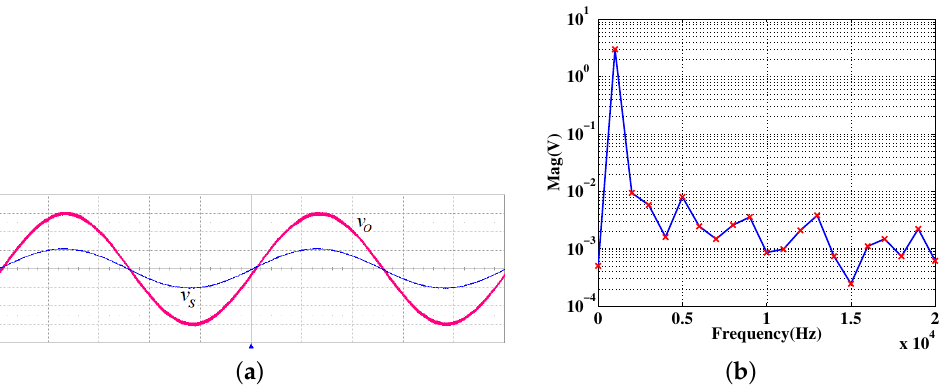
Figure 13. ( a ) v s and v o waveforms at 1 kHz: v o (1 volt/div), v s (0.1 volt/div), timescale: (200 micro- seconds/div) ( b ) frequency spectrum of 1 kHz output